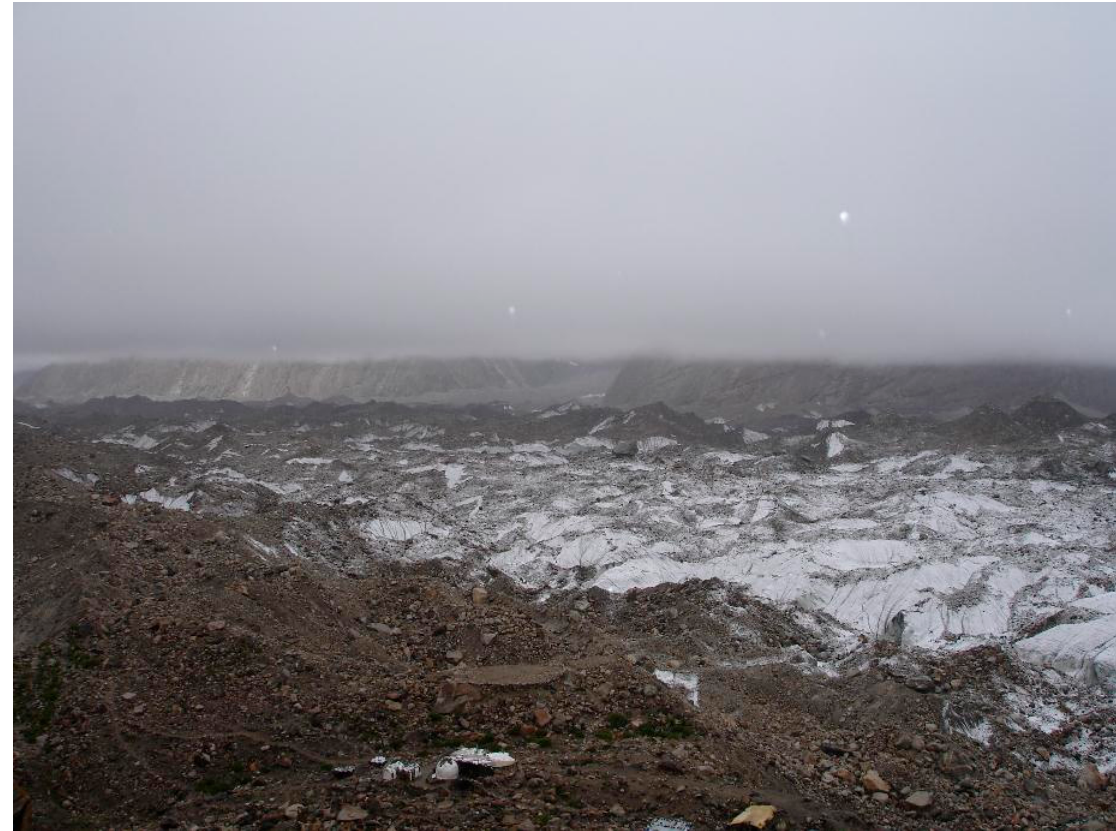
Figure 2. Monsoon snowfall on the Baltoro glacier, as seen from Urdokas (photo credit: Andrew G.B. Bush, 2005).